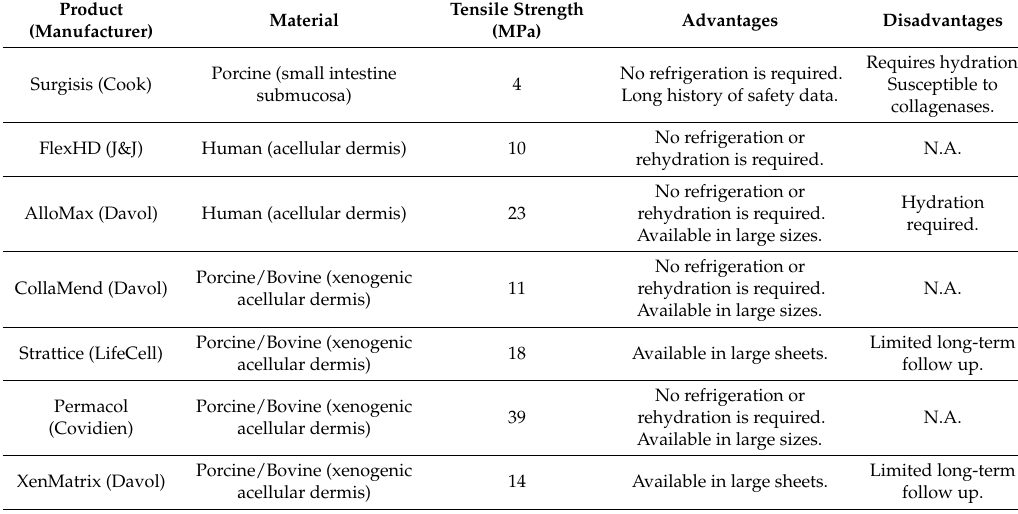
Table 3. Classification of commercially available third generation surgical meshes